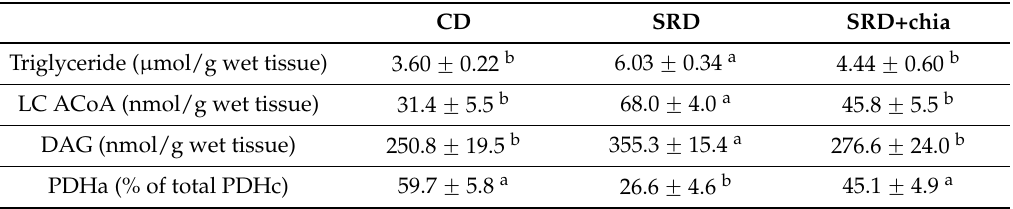
Table 6. Intramyocardial lipid accumulation and PDHc activity of rats fed a control diet (CD),